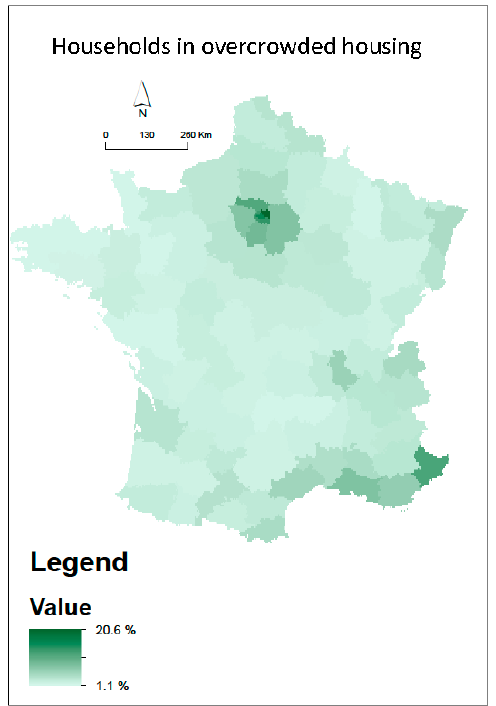
Figure 3. Spatial distribution on the French department scale of the percentage of households living in overcrowded housing.